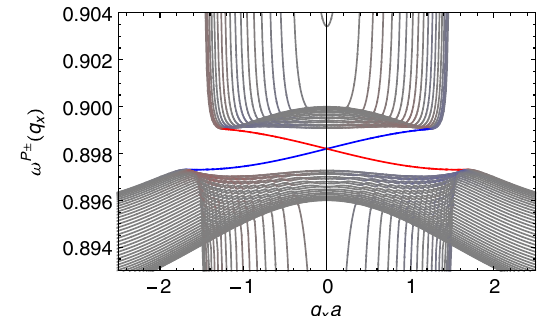
FIG. 4. Schematic experimental setup for realizing topolaritons. FIG. 3. Topological polariton spectrum. Spectrum obtained for A quantum well (in blue) is embedded in a photonic waveguide a tight-binding lattice analog of the Hamiltonian Eq. (1) on a (or cavity). The boundary of the light blue disks represent square lattice with periodic (open) boundary conditions in the x equipotential lines of the periodic exciton potential with lattice direction ( y direction). Two edge modes are found within the gap, constant a (see Sec. IIIB). each localized at one of the system boundaries. The color scale encodes the edge localization, where red (blue) indicates a large weight of the wave function at the edge at y ¼ 0 ( y ¼ L ). For the construction of the lattice model, we choose quadratic dispersions 2 = 2 m þ ω X q 2 = 2 m for the exciton and photon, respec- 0 and q X C → 2 − 2 cos ð q Þ (note that a quadratic tively, replacing q 2 x;y x;y ¼ q = 2 c correctly reproduces the photon dispersion with m C res original linear dispersion close to resonance at q ). Similarly, res Þ þ i sin ð q Þ(cid:2) . we model the winding coupling by g q ¼ g ½ sin ð q x y The system size is 40 × 40 (with lattice constant a ¼ 1 ), and the ¼ − 500 , m ¼ 1 , other relevant parameters are given by m X C ω X ¼ 0 . 25 , and g ¼ 0 . 01 0